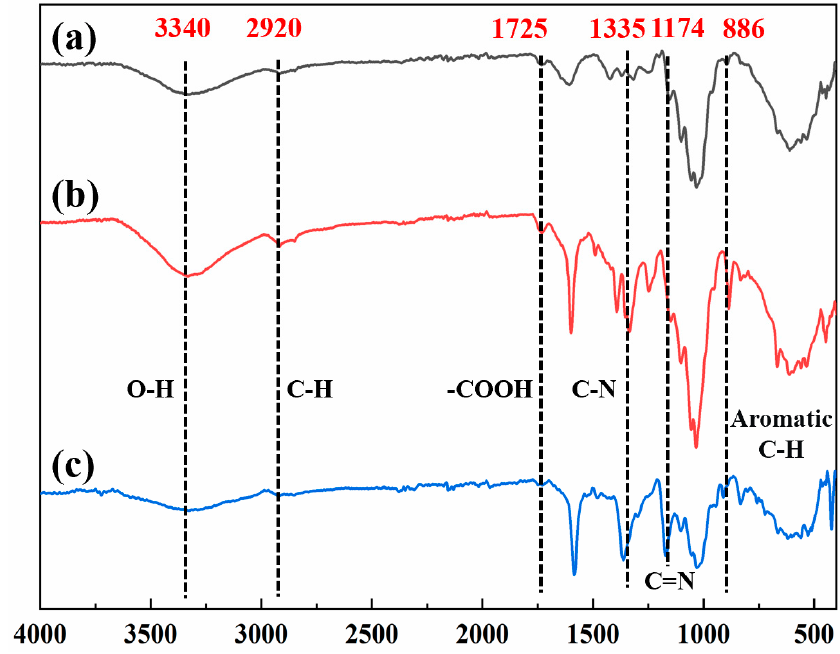
Figure 2. FTIR spectra of ( a ) MT, ( b ) MT-MB, and ( c ) MT-CV. Table 1. Pore characteristics of different